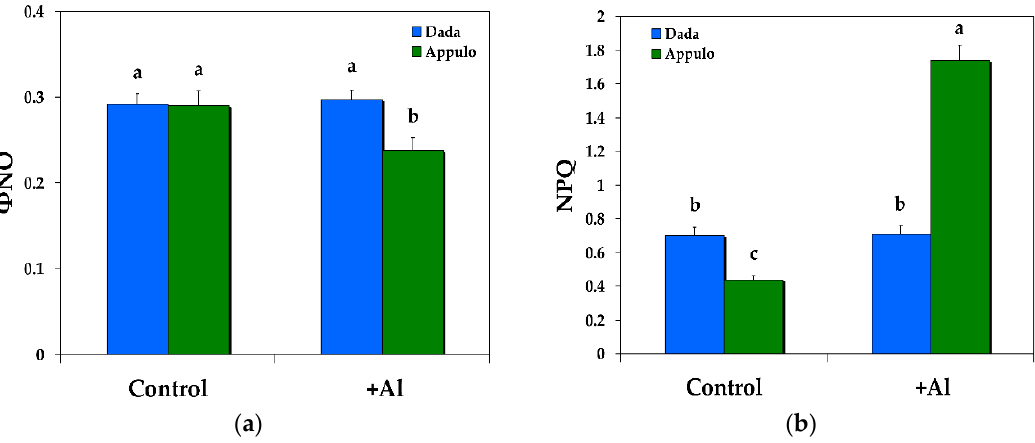
Figure 3. Changes in the quantum yield of non-regulated energy dissipated in PSII (non-regulated heat dissipation, a loss process due to PSII inactivity) ( Φ NO ) ( a ); and changes in non-photochemical fluorescence quenching (NPQ) ( b ); in the triticale ‘Dada’ and the durum wheat ‘Appulo E’, under normal growth conditions (control) and under Al 3+ exposure (+Al). Error bars on columns are standard deviations based on five leaves from five plants. Columns with different letters are statistically different ( p < 0.05).